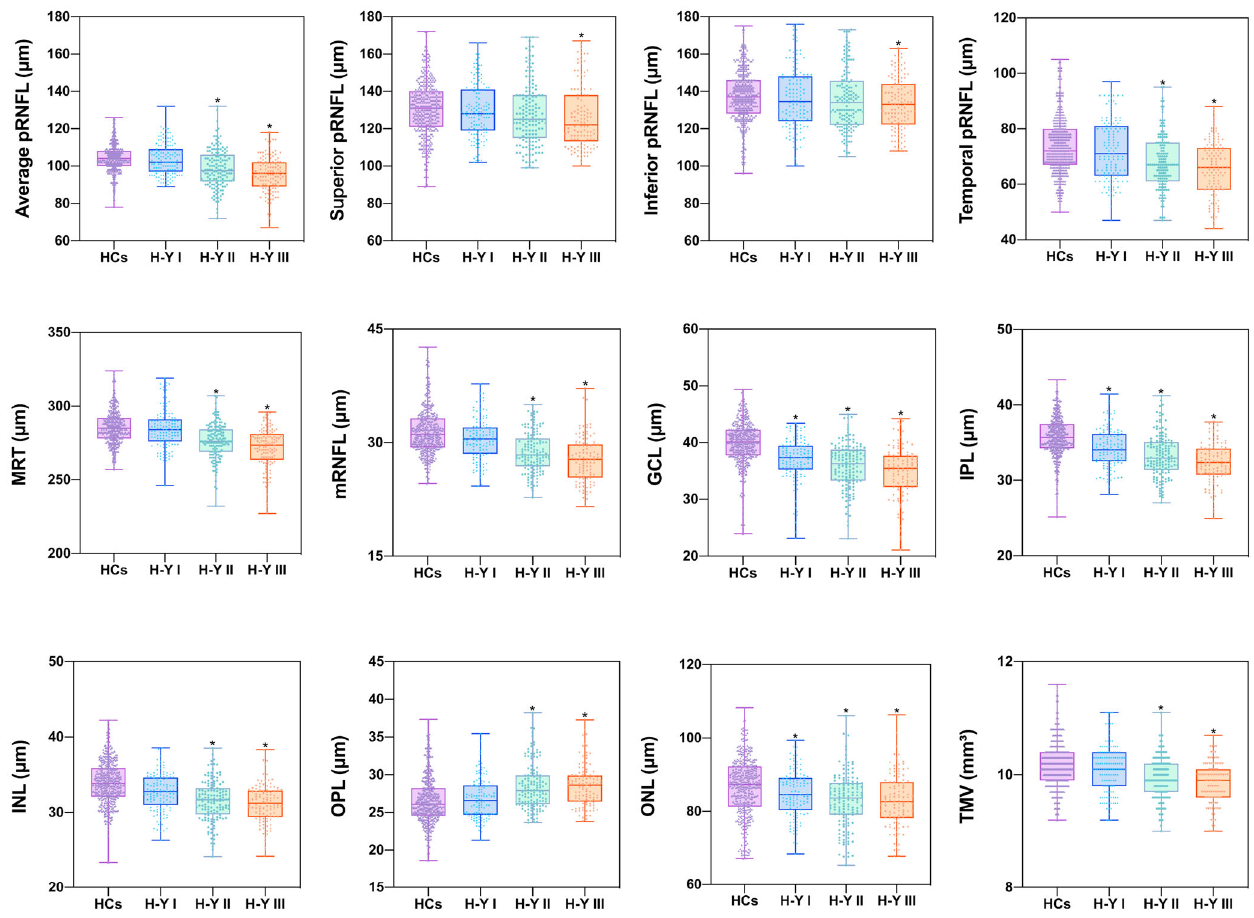
Fig. 3 The retinal parameters in patients with Parkinson ’ s disease at different clinical stages versus healthy controls. Patients with PD had a thicker OPL and thinner mRNFL, GCL, IPL, INL, and ONL. These tendencies were more pronounced with higher Hoehn-Yahr staging scores. In addition, signi fi cant thinning of the GCL, IPL, and ONL could be detected early in patients with PD with the H-Y I stage. Box-and-whisker plots represent the median (bar), interquartile (box), min and max values (whiskers). HCs healthy controls, PD Parkinson ’ s disease, H-Y Hoehn-Yahr, pRNFL peripapillary retinal nerve fi ber layer, MRT macular retinal thickness, mRNFL macular retinal nerve fi ber layer, GCL ganglion cell layer, IPL inner plexiform layer, INL inner nuclear layer, OPL outer plexiform layer, ONL outer nuclear layer, TMV total macular